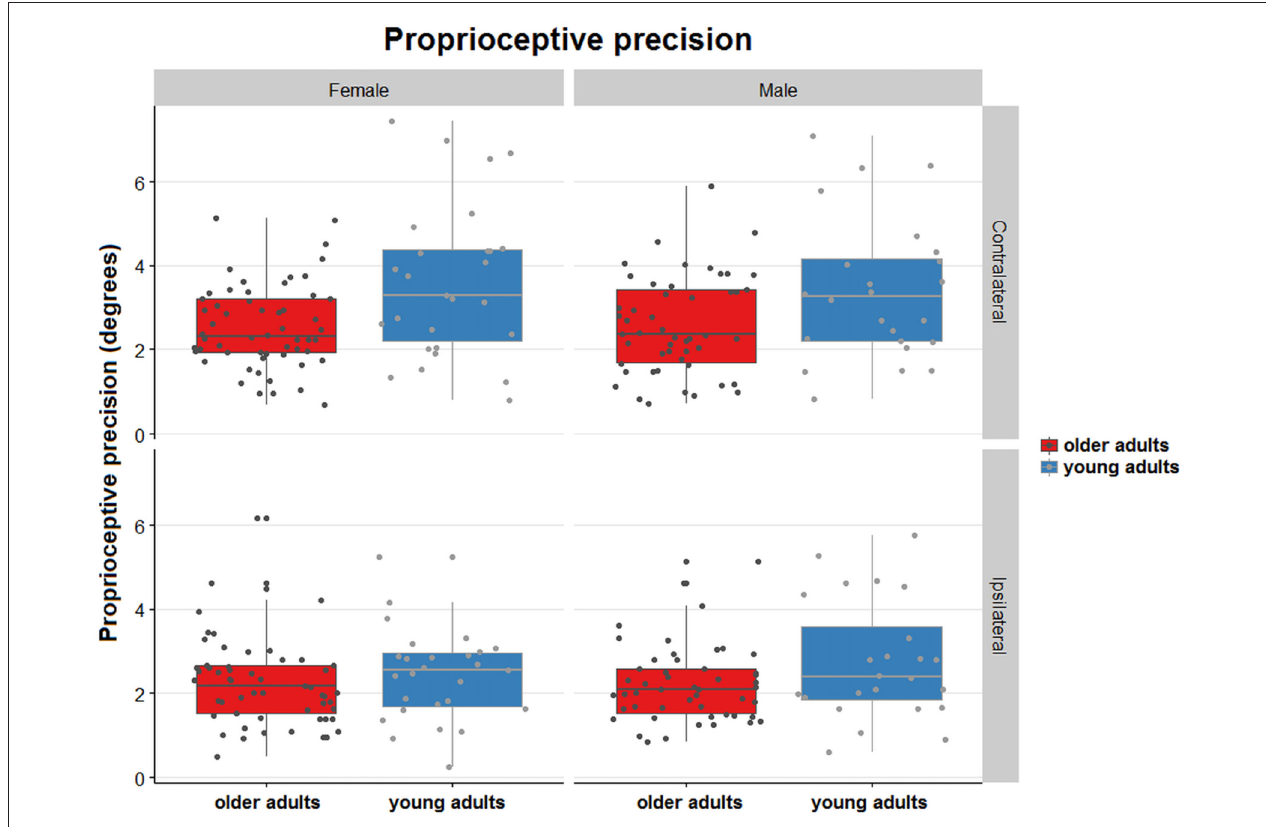
FIGURE 5 | Distribution plots of proprioceptive precision for contralateral and ipsilateral matching in young and older females and males. Proprioceptive precision over the 5 trials/task for both joint position matching tasks. The dots are randomly jittered to avoid point spatial overlap. The degree of error in proprioceptive precision is represented for each type of task, sex, and age group. The colored boxes represent the mean and standard deviation of the proprioceptive precision for the type of task, sex and age